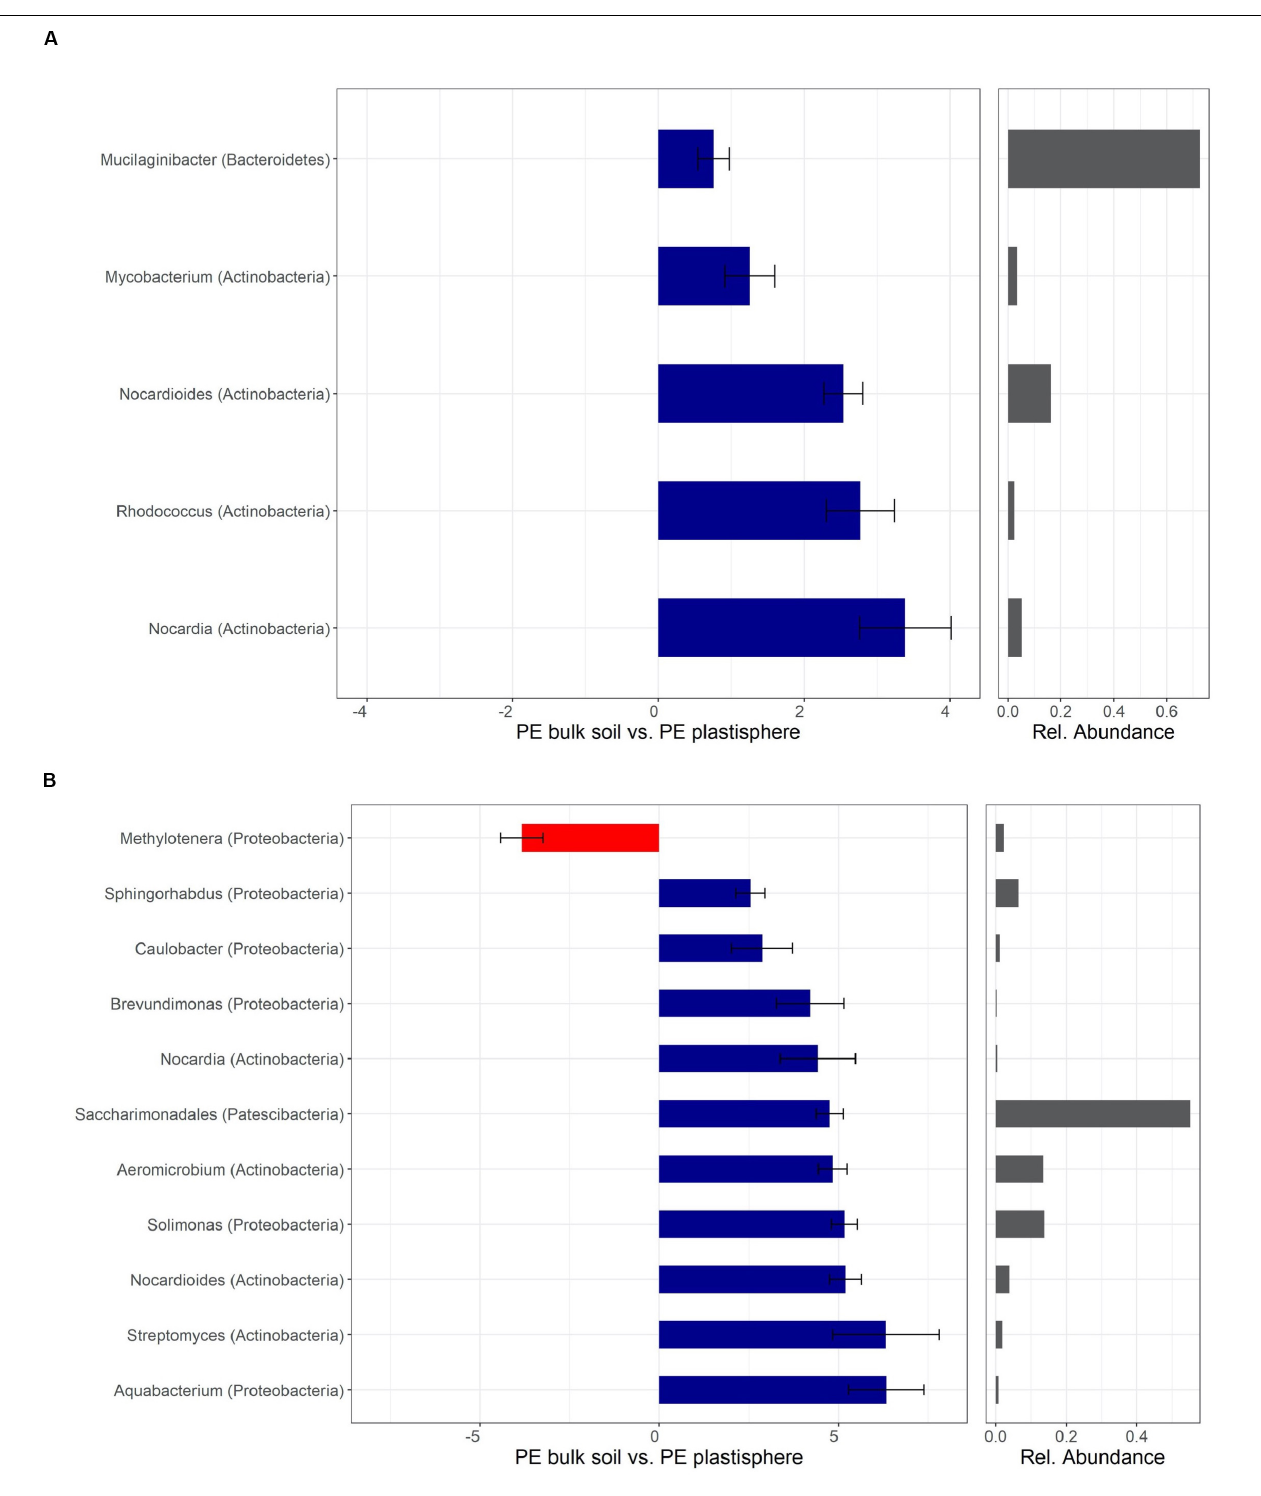
FIGURE 7 | Differentially abundant taxa of PE in Barba Peider (Swiss Alps) (A) and Villum (Northern Greenland) (B) soil. Taxa are classified to the lowest possible taxonomic level. Values on the X -axis in the left panels show the differential abundances in the plastisphere and bulk soil as log 2 -fold changes. Only significant taxa ( P < 0.05) with log 2 -fold changes > 2.5 are shown. Note that the scales in the x -axis in panels (A,B) are different. Positive values indicate a higher occurrence in the plastisphere, whereas negative values indicate a higher occurrence in the bulk soil. Names in brackets specify the phylum the taxa belong to. Values in the right panels indicate the abundances of specific taxa relative to the taxa shown in the